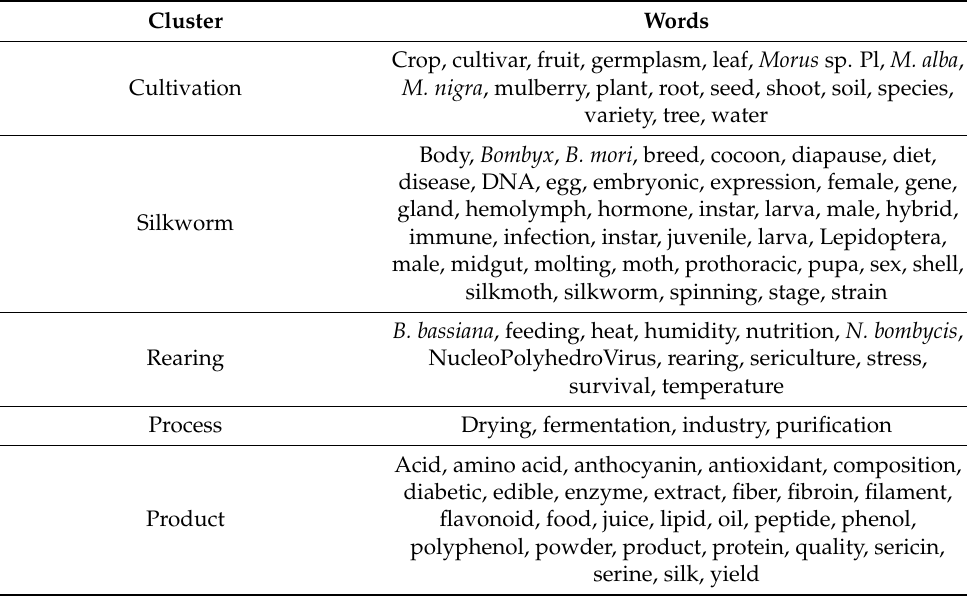
Table 2. Name of the considered clusters and words that compose them. Cluster Words